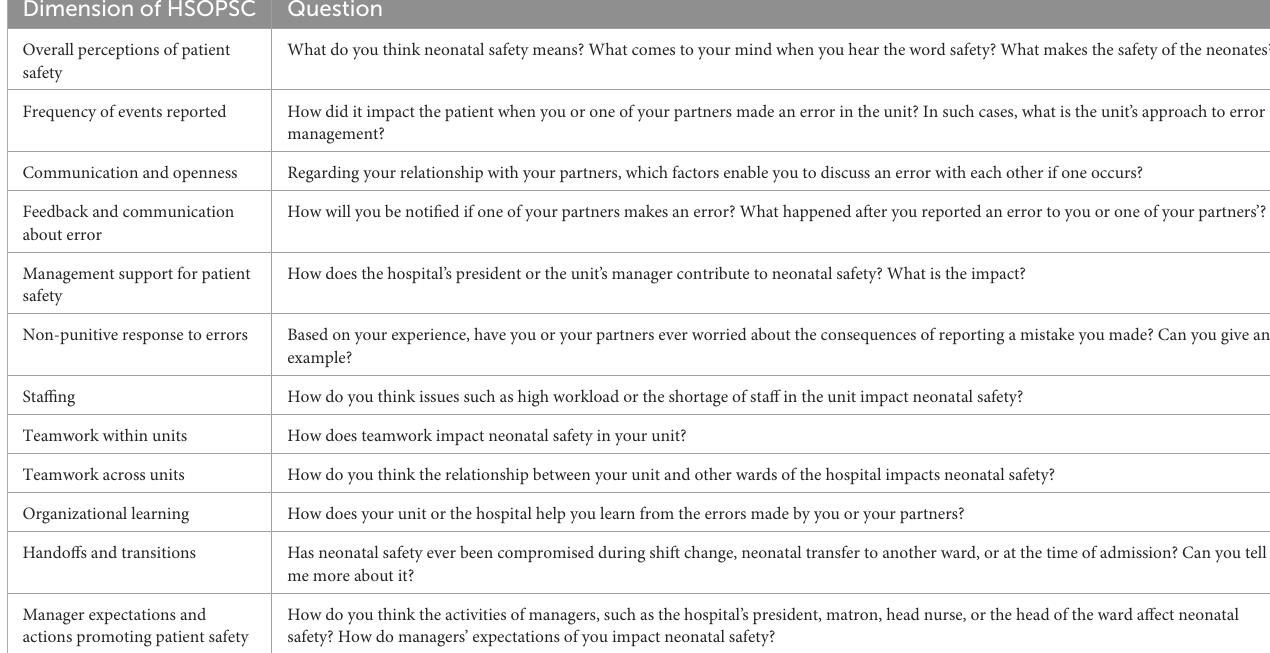
TABLE 1 Interview guide based on HSOPSC